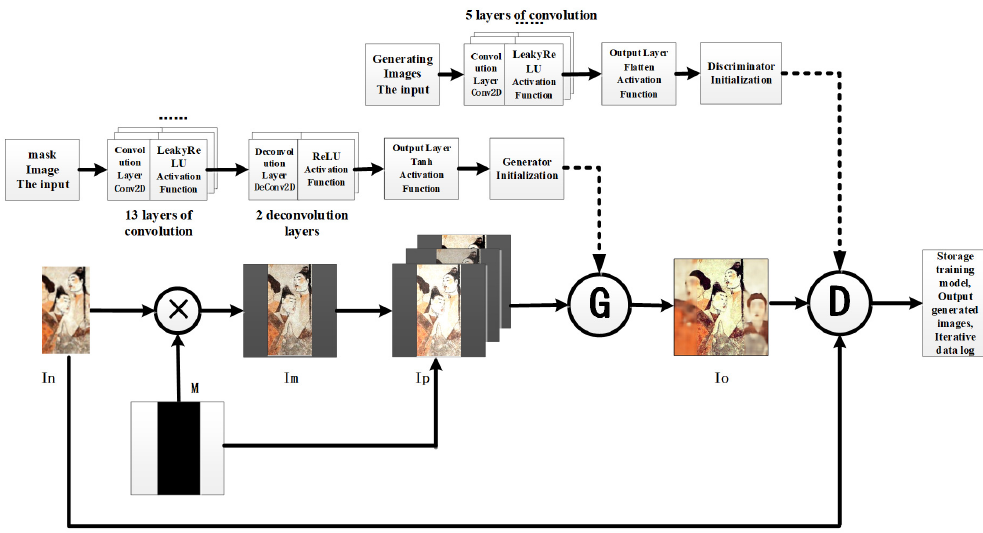
Fig. 4 The information generation flow chart on tomb mural